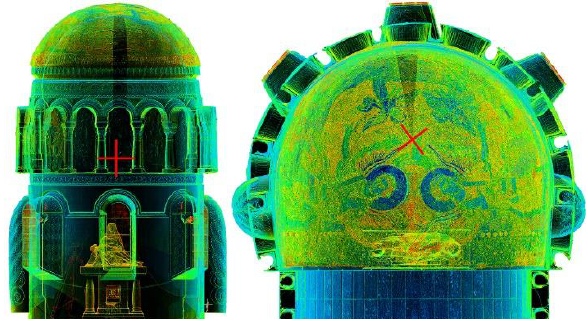
Figure 2 Top View and Side view of TLS data, with the optical TLS centre’s position (red cross)